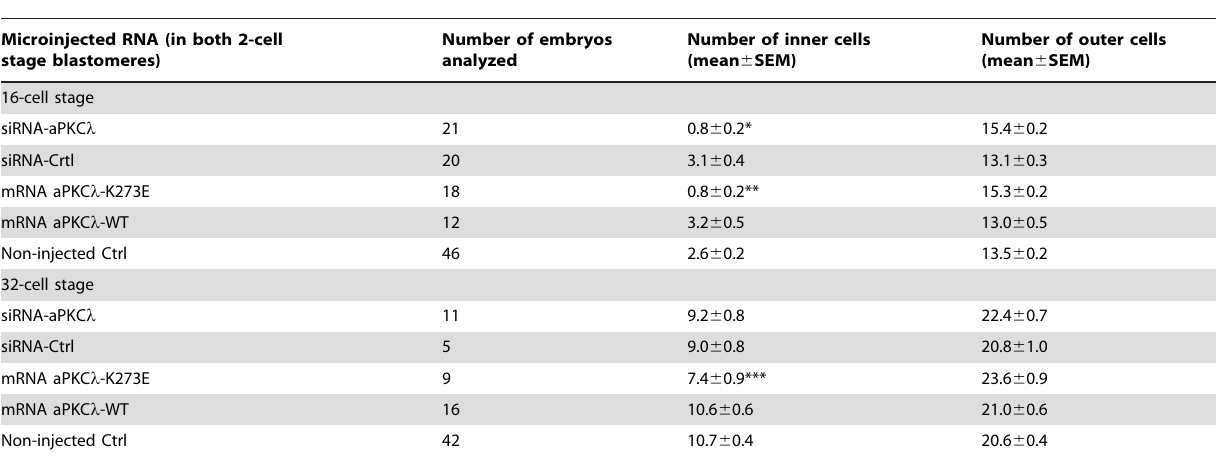
Table 2. Effect of aPKC l -depletion on cell allocation in 16- and 32-cell stage embryos.